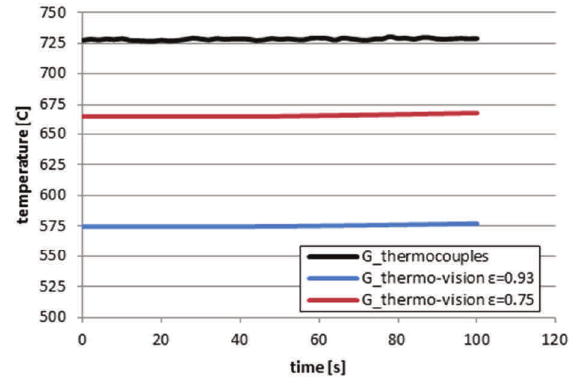
Fig. 9. Comparison of temperature values for exhaust manifold derived from thermocouple and thermo-graphic images (different emissivity)